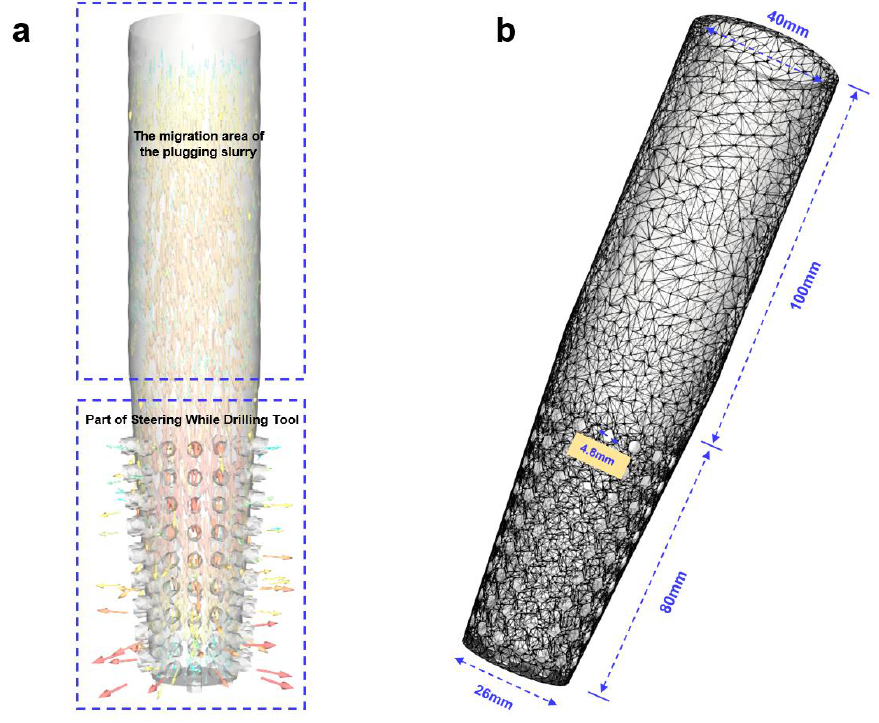
Figure 4. ( a ): Slurry migration from the mud screen tool. ( b ): Mud screen tool size and grid. The diameter of the circle at the upper end of the mud screen tool is 20 mm, which is consistent with the cross-sectional diameter of the cylindrical structure. The diameter of the circle at the lower end is 26 mm. The overall height is 80 mm, and the cone angle is − 8.58 ◦ . The conical part contains 144 holes with a diameter of 4.8 mm. The scale of the model is 1:1 with the size of the actual tool. The dimension of the entire computational domain is 0.0446 m × 0.1805 m × 0.0446 m, with a total of 54,891 boundary faces and 61,478